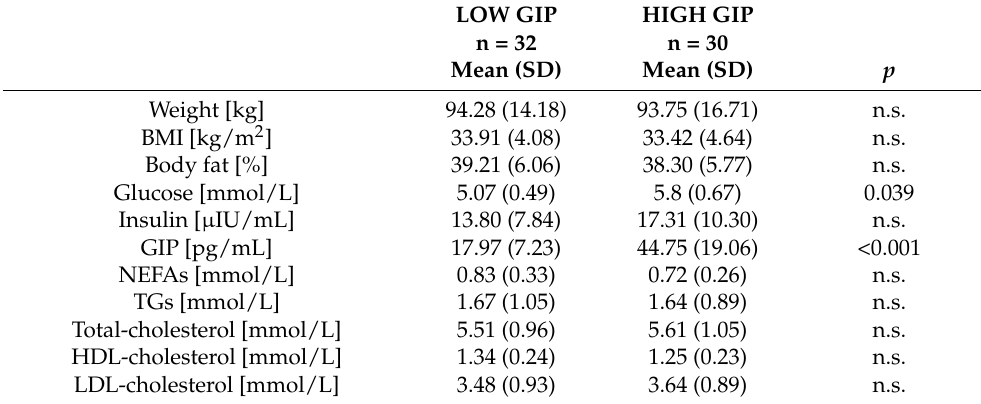
Table 3. Characteristics of participants according plasma GIP level at baseline.